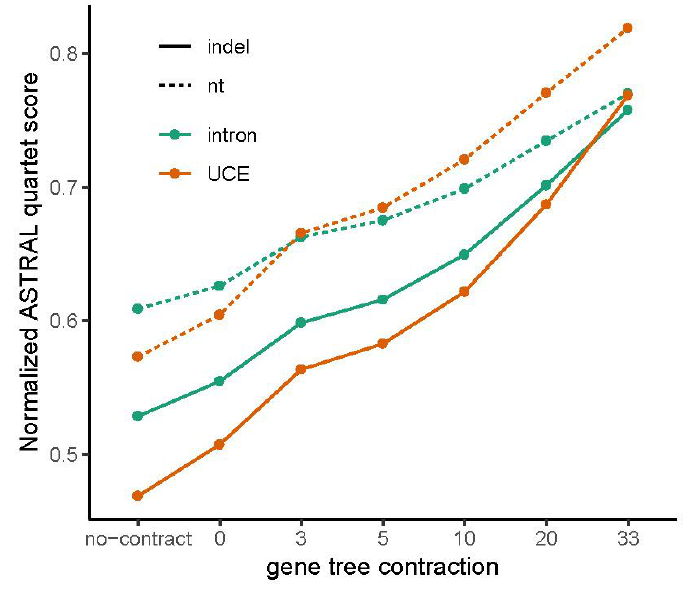
Figure 10. QS of the ASTRAL tree computed from intron and UCE, indel and nt gene trees at levels of gene tree contraction from 0 – 33%. UCE indels yield uniformly lower QS than intron indels and nt data and removing low support branches increases the QS of the ASTRAL